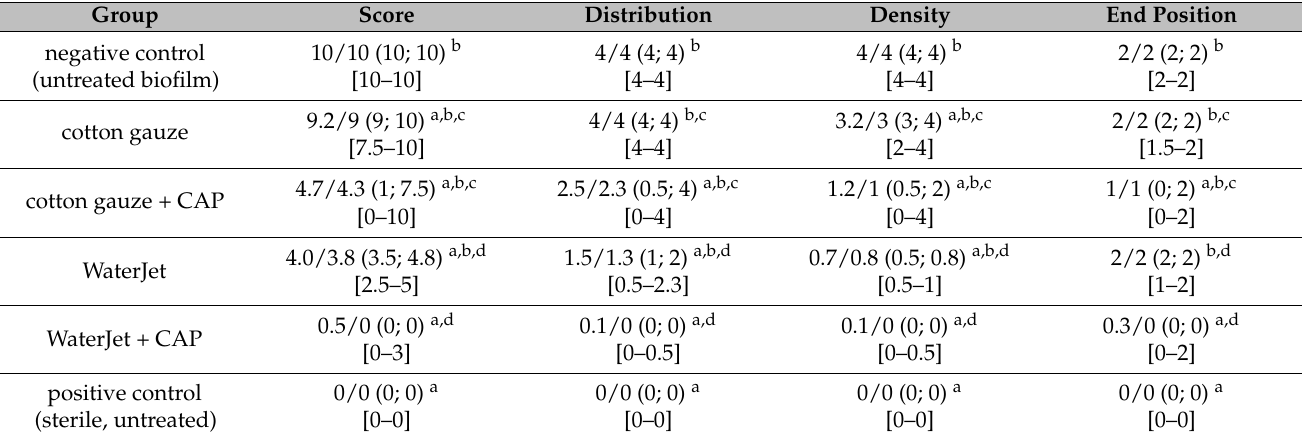
Table A1. Distribution of variables presented as mean/median (25th percentile; 75th percentile) [min-max] and pairwise comparisons between groups of bacterial agar growth analysis. Groups were compared for differences using Mann-Whitney-U Test: a statistically significant difference to the negative control; b statistically significant difference to the positive control; c statistically significant difference between cotton gauze and cotton gauze + CAP; d statistically significant difference between WaterJet and WaterJet + CAP.